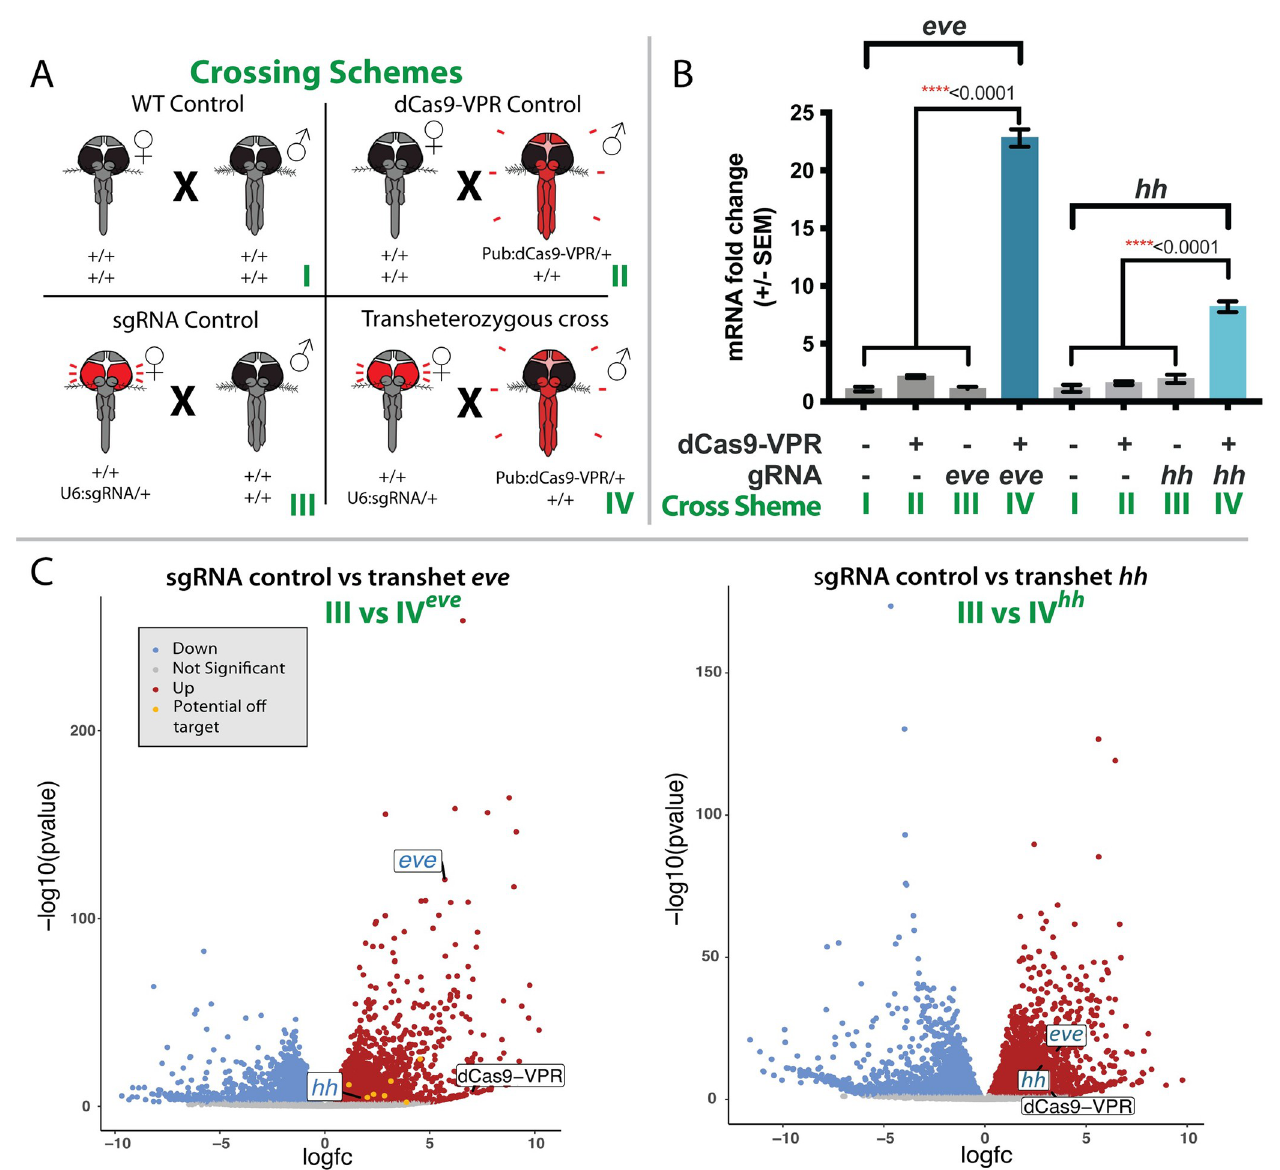
Fig 2. Quantified overexpression of CRISPRa transactivation. A) Multiple crosses were performed in order to determine if the CRISPRa system could transactivate target genes. Crosses included a wild-type control (+/+ ♀ X +/+ ♂ , I), dCas9-VPR Control (+/+ ♀ X Pub:dCas9-VPR/+ ♂ , II), sgRNA control (+/U6:sgRNA ♀ X +/+ ♂ , III), and a transheterozygous cross (+/U6:sgRNA ♀ X Pub:dCas9-VPR/+ ♂ , IV). B) Fold change of expression of targeted genes from CRISPRa transactivation was measured and calculated using qPCR. Differences in mRNA fold change between control crosses and transheterozygous crosses were calculated using a one-way ANOVA and Tukey’s multiple-comparison test, ���� p < 0.0001 (F 3,8 = 659.7; P = 6.46e-10;F 3,8 = 82.67; P = 2.32e-06 for eve and hh respectively). C) Volcano plots of the RNA sequencing data were to compare expression levels of eve and hh as well as other genes potentially affected. Down-regulated genes are colored blue while upregulated genes are in red. Potential off-target genes are in yellow.